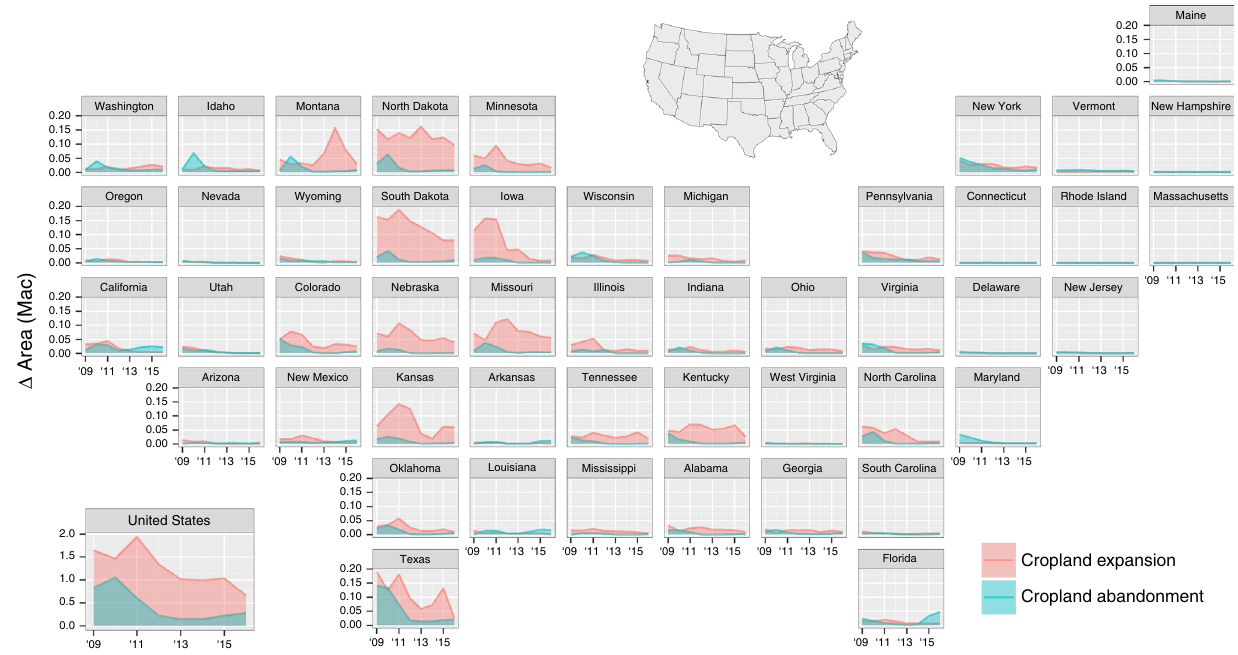
Fig. 2 Annual cropland expansion and abandonment by state, 2008 – 16. The values for each year re fl ect the gross areas of cropland expansion and abandonment that occurred between that year ’ s growing season and that of the previous year — i.e., conversions for 2008 – 09 are reported as ‘ 09. Iowa, Kansas, South Dakota, and Texas experienced some of the greatest transformations to cropland, with their rates of expansion cresting in earlier years and falling over time. Minnesota, Missouri, and Nebraska exhibited similar temporal trends but at lower magnitudes. High rates of expansion in North Dakota and, to a lesser extent, Kentucky, were persistent across the full study period. Montana was the only state with greater conversion to cropland after 2012 than